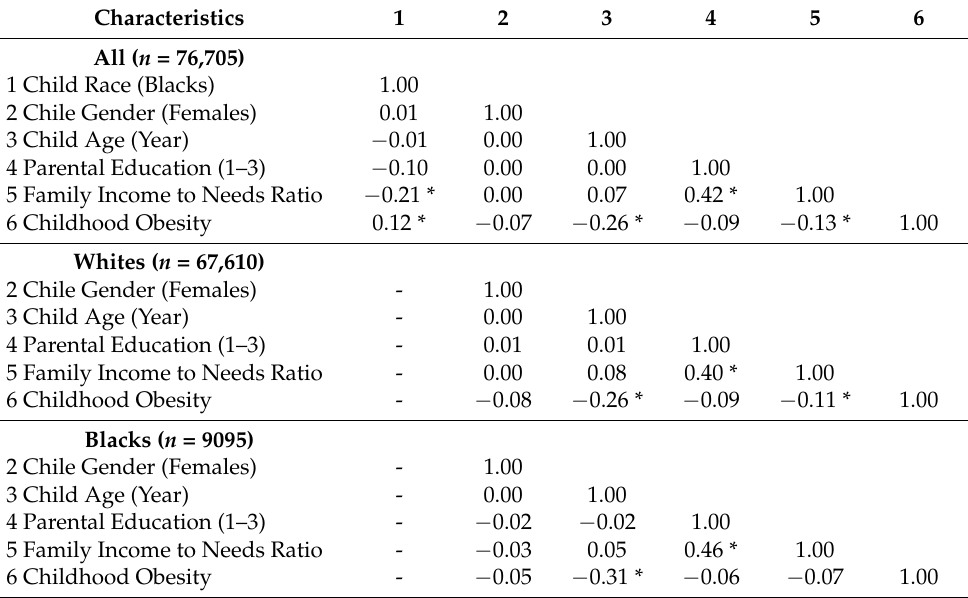
Table 2. Correlation matrix in the pooled sample and by